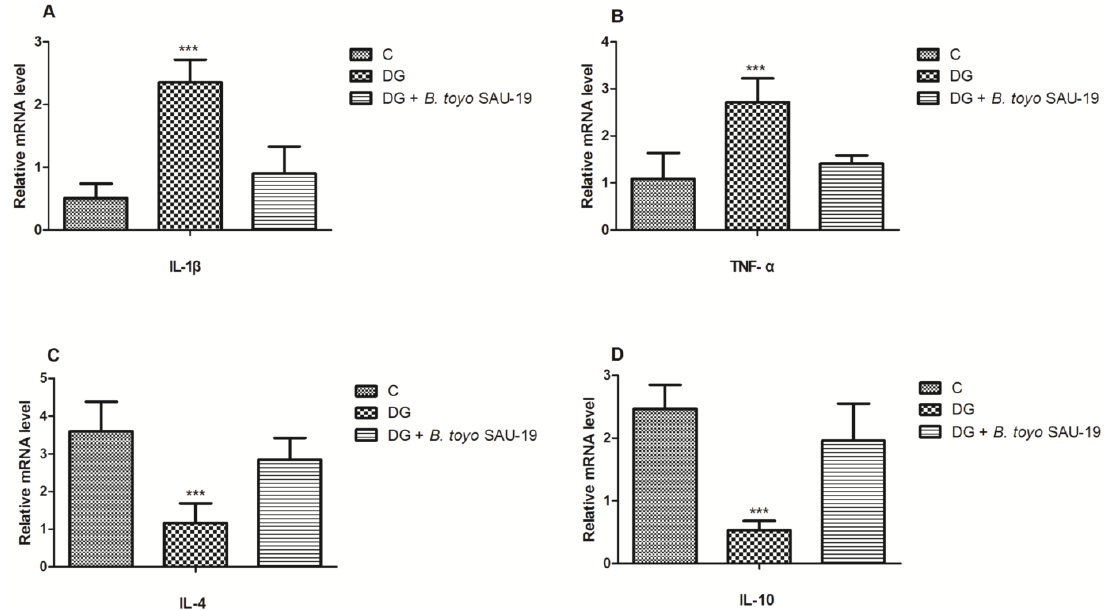
Figure 7. Effects of Bacillus toyonensis SAU-19 on relative mRNA expression of pro- and anti-inflammation-related cytokines in HFD/STZ-induced T2DM mice. ( A , B ) mRNA expression levels of pro-inflammation cytokines. ( C , D ) mRNA expression of anti-inflammatory cytokines. Values are shown as mean ± Sd. Bars with *** are statistically different ( p < 0.05). DG compared with the control (C) and B. toyo SAU-19 groups ( n = 6).